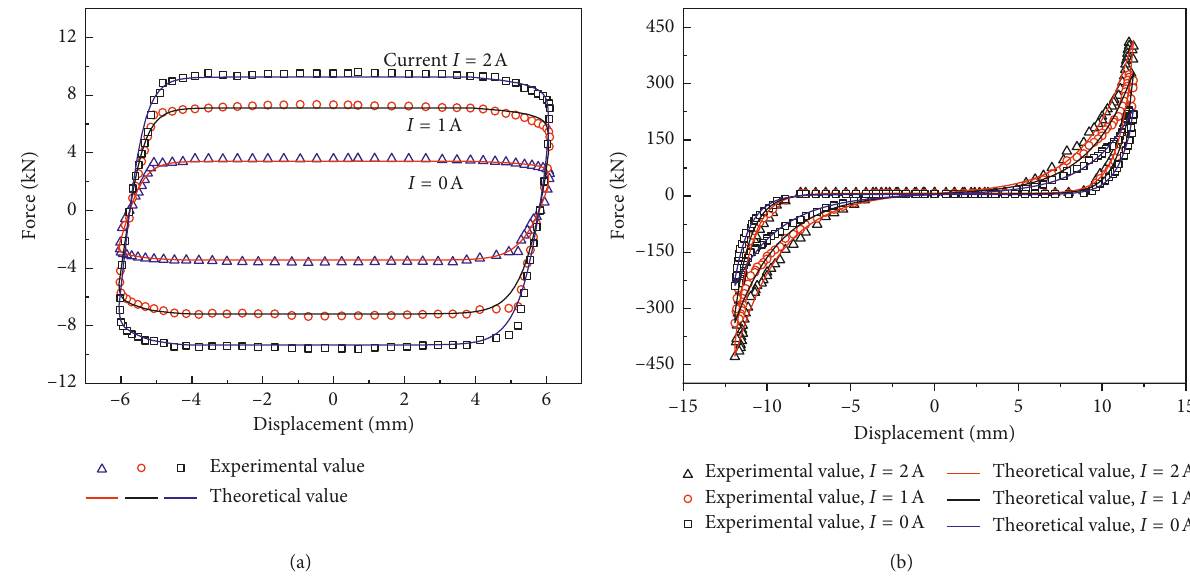
Figure 15: Comparison between theoretical and experimental results of the isolator. (a) Small displacement. (b) Large